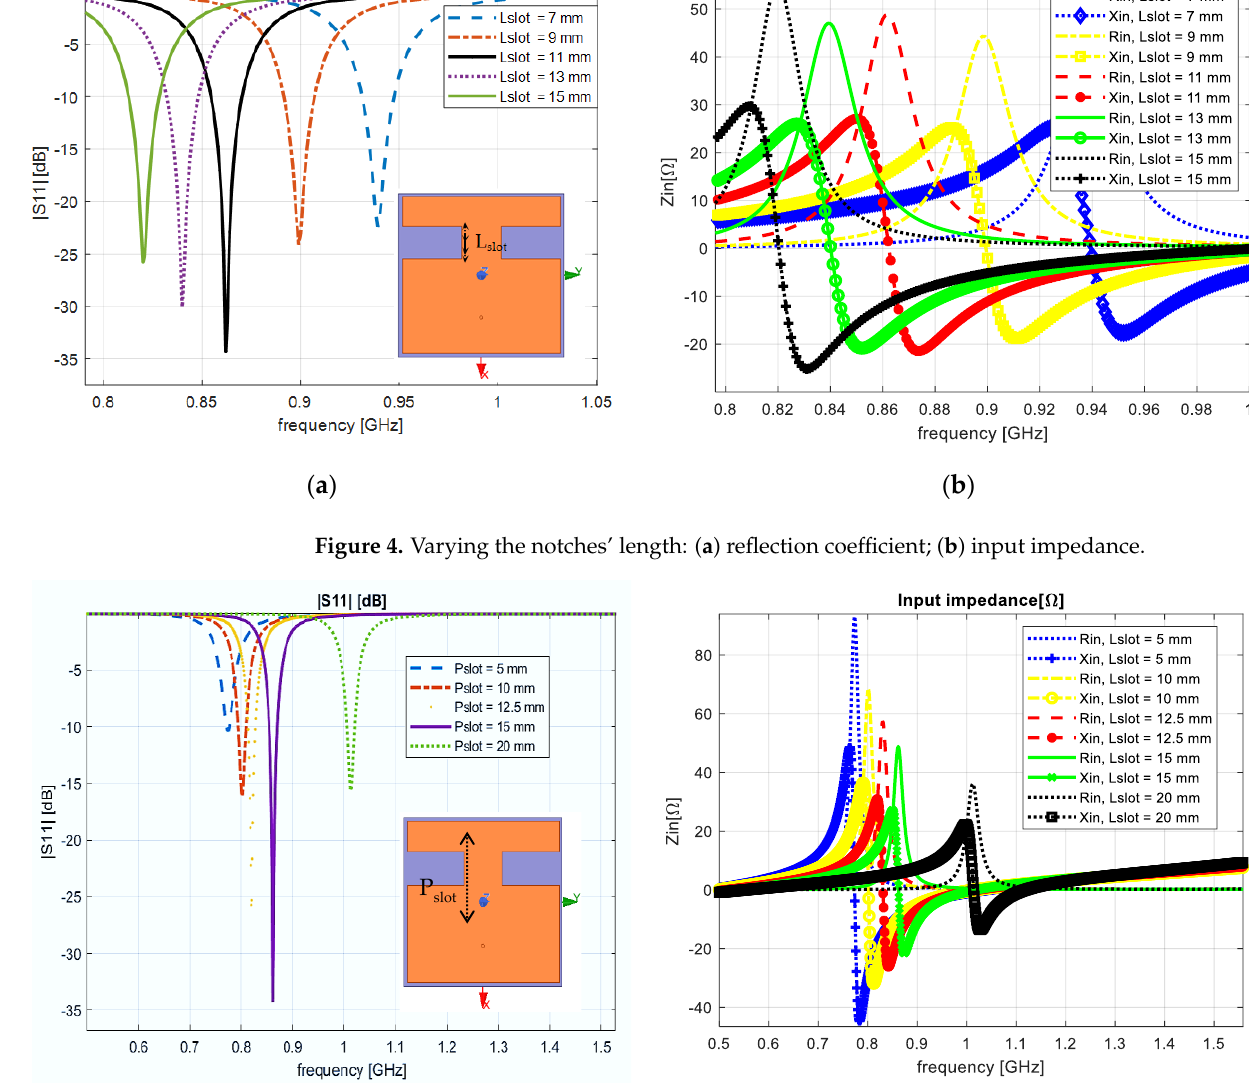
Figure 4. Varying the notches ’ length: ( a ) reflection coefficient; ( b ) input impedance.